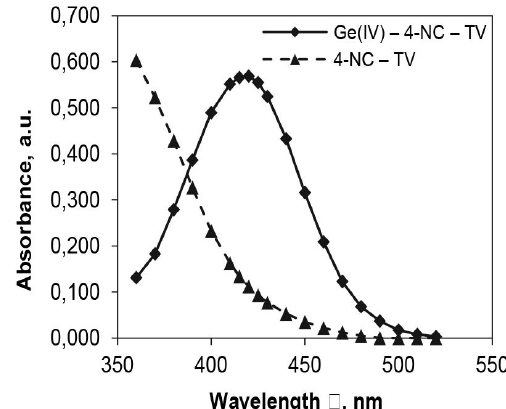
Figure 1. Absorption spectra of the complex Ge(IV)‒4-NC‒TV and of the blank sample 4-NC‒TV in CHCl 3 ; C Ge(IV) = 2.0 × 10 –5 mol L –1 ; C 4-NC = 5.0 × 10 –4 mol L –1 ; C TV = 1.5 × 10 –4 mol L –1 ; pH = 4.0; λ = 420 nm; τ = 2